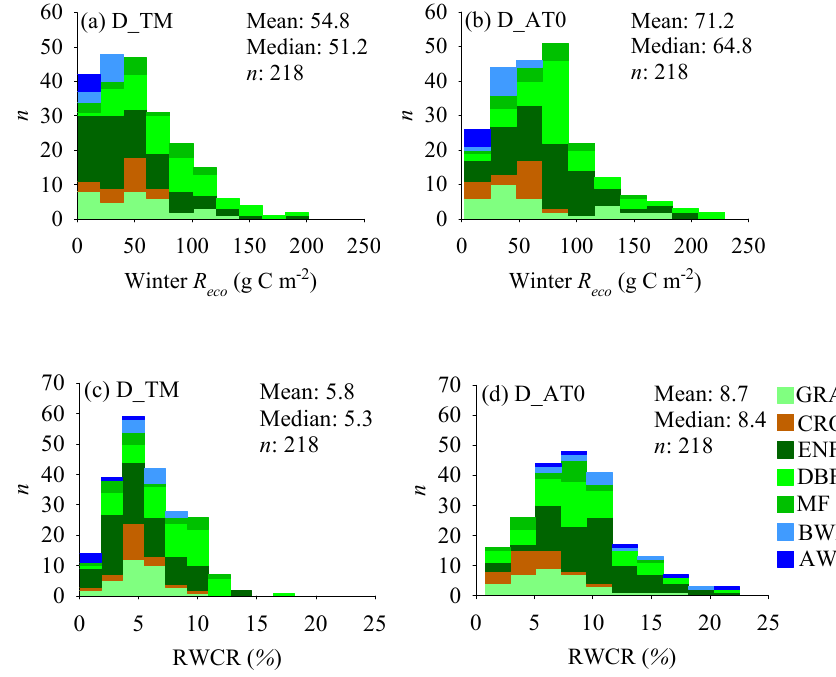
Fig. 1. Frequency histograms of winter cumulative R eco and the ratio of winter cumulative R eco to annual cumulative R eco (RWCR) (%) according to winter definition D TM (December–February) and D AT0 (air temperature < 0 ◦ C) across all of the site-years. n is the number of site years.